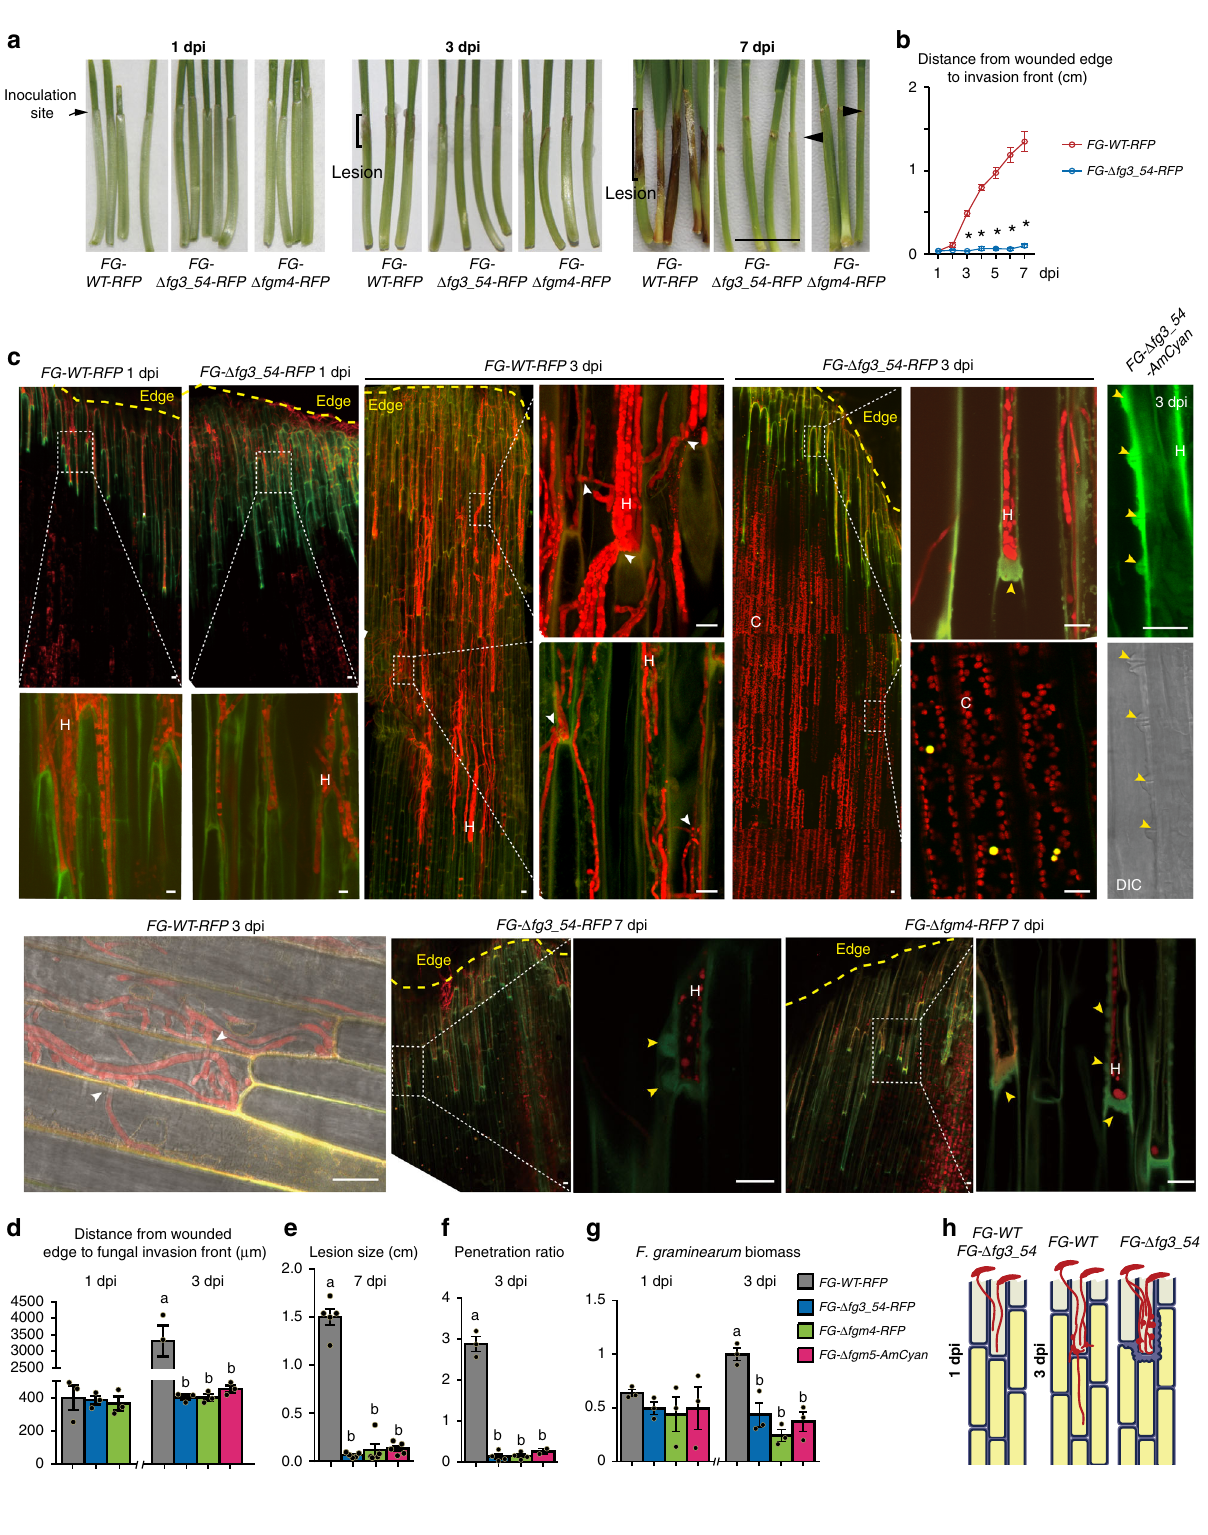
FGM4 turns on the expression of fg3_54 -related genes . The above fi ndings demonstrated the involvement of a diffusible fg3_54 -related product in the cell-to-cell penetration process in wheat infection and thus generated interest in the functions of genes within this sequence. Fg3_54 contains nrps5 and nrps9 , both of which encode NRPSs (Fig. 1a). NRPSs are often giant proteins in which functional domains are organized into modules. Each module typically consists of an adenylation (A) domain